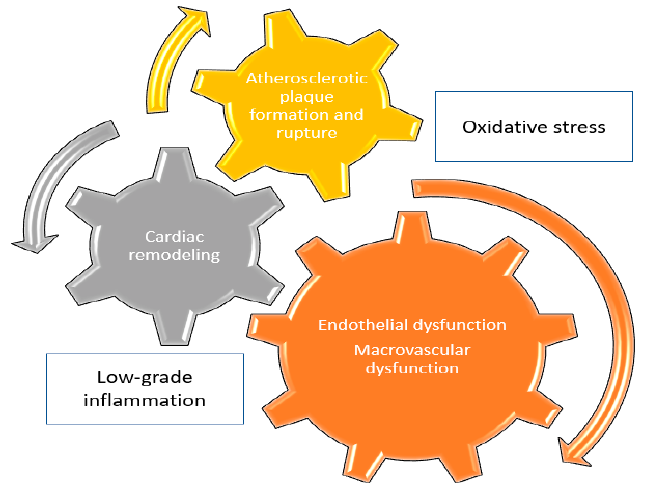
Figure 1. Major pathophysiologic mechanisms implicated into CVD pathogenesis and affected by IL-1 and IL-6.